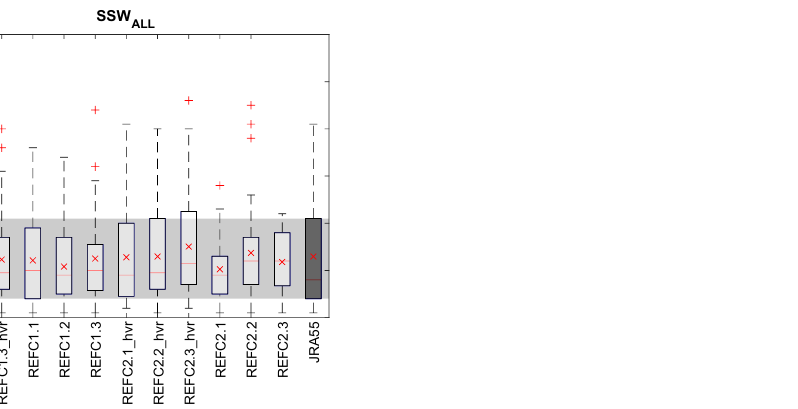
Figure 2. Duration of SSWs. The red line inside the boxes marks the median. The ‘ × ’ indicates the mean, and the error bars show the range of typical values of the sample. Outliers are data point values ≥ 1.5 times the interquartile range are marked with red crosses, and the height of the box indicates the interquartile range (IQR). Error bars were calculated as follows: Values lower than Q1 − 1.5 · IQR or higher than Q3 + 1.5 · IQR are considered atypical. Where IQR is the interquartile range, Q1 is the first quartile (25th percentile) and Q3 is the third quartile (75th percentile). The box in dark shading represents the reanalysis data, and the shading its interquartile range. None of the simulations is significantly different from the reanalysis at the 0.05 level.